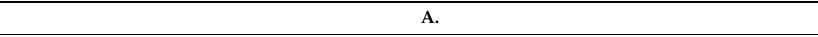
Table 2. Performance of CHIKV E1 / E2 Lateral Flow Test. Area under curve (AUC) of ROC curve, 95% confidence interval (95% CI), signal intensity cuto ff , sensitivity (%), specificity (%), and sample counts were calculated for incremental PCR Ct cuto ff s for the E1 / E2 lateral flow test using antibody Combination A (48 and 155) in Honduras ( A ) and antibody Combination B (4 and 340) in Honduras ( B ) and Colombia ( C